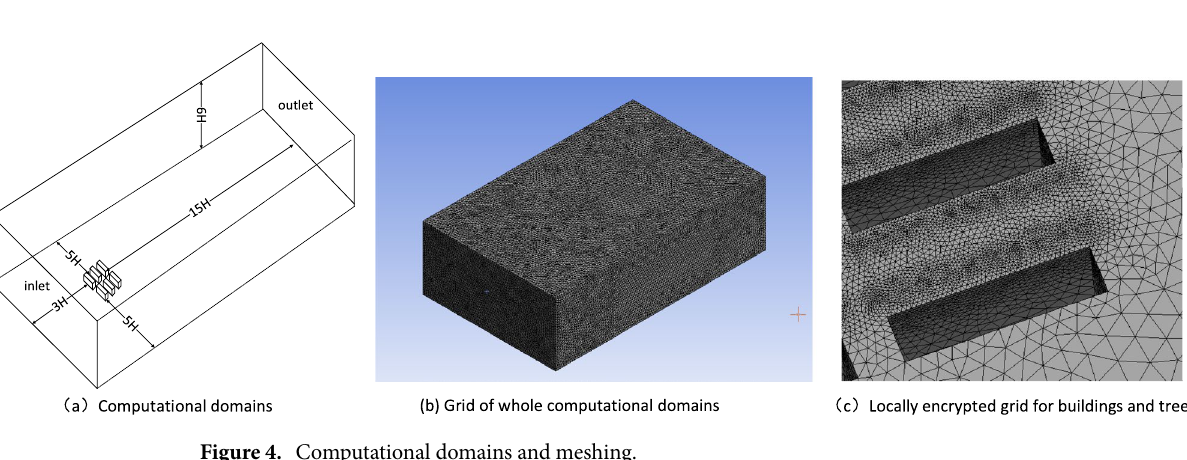
Figure 3. Distribution of field measurement sites. The aerial map was obtained via Baidu Map, and all the other images were taken by the authors.